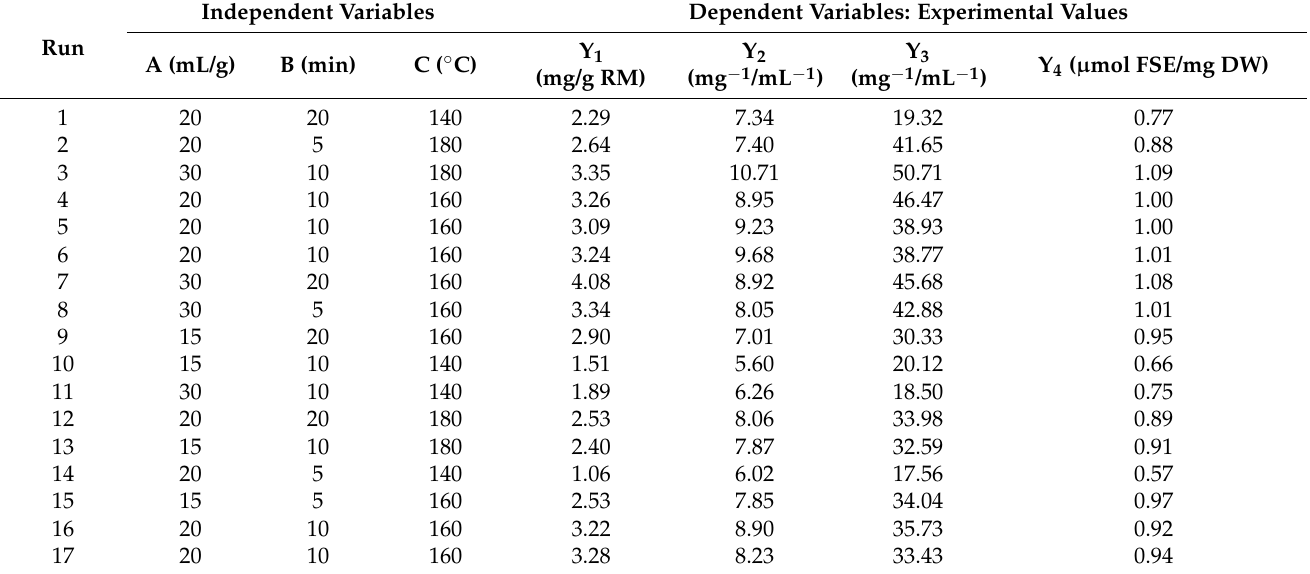
Table 4. Independent variables and experimental data of the response design for the PHWE of phenolic antioxidants from Bambusa chungii culms.